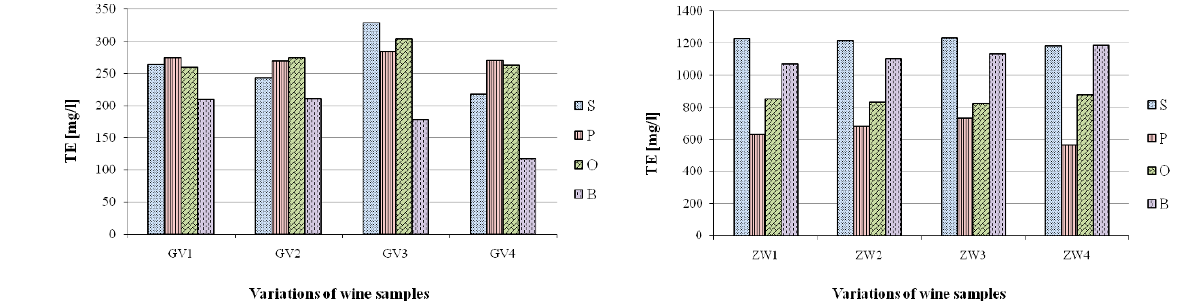
Figure 2. Total phenolic contents in 16 white wine samples from individual experimental vineyards in Czech Republic (S, P) and Austria (O, B). SDs values see Table 2